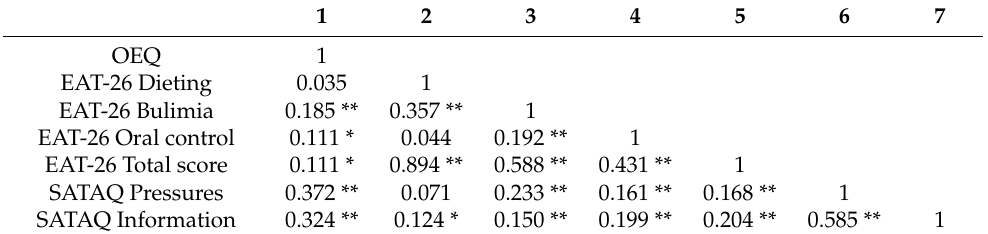
Table 2. Pearson correlation between OEQ, EAT-26, and SATAQ